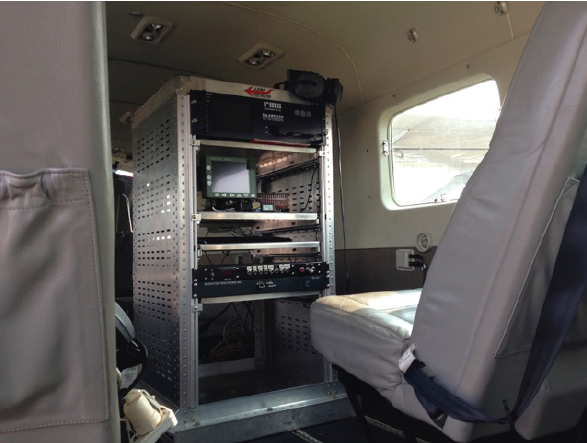
Figure 8. DAARC 500 in operation (source: E. Camara, private col- lection, September 2015).